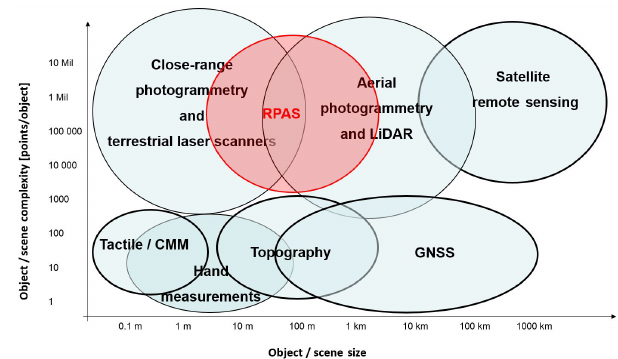
Figure 1. Available geomatics techniques, sensors and platforms for topographic mapping or detailed 3-D recording of ground informa- tion, according to scene dimensions and complexity (modified from Nex and Remondino,